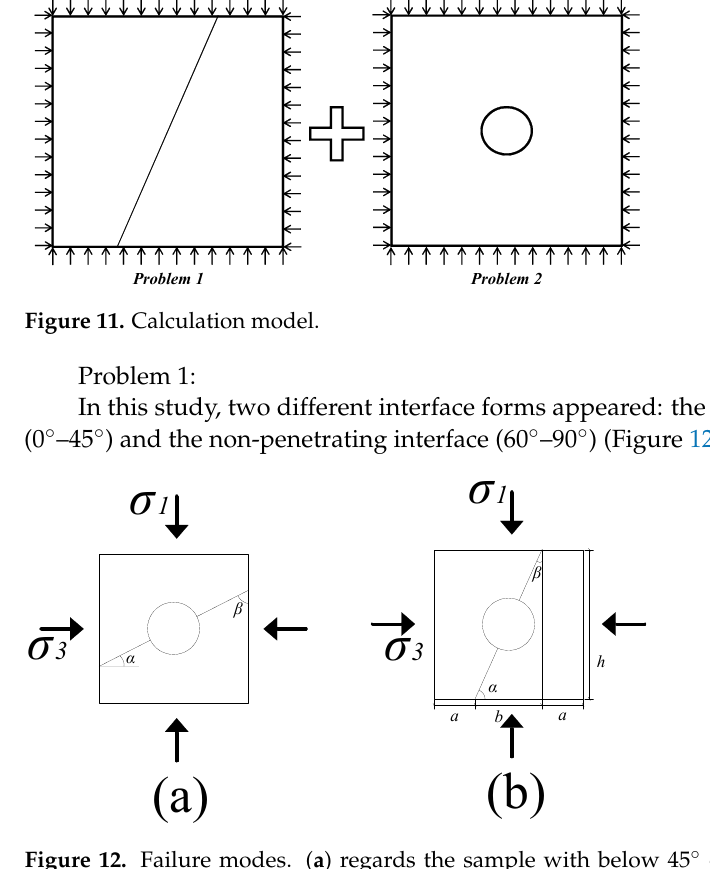
Figure 12. Failure modes. ( a ) regards the sample with below 45 ° dip angle of structural plane, ( b ) regards the sample with above 45 ° dip angle of structural plane.